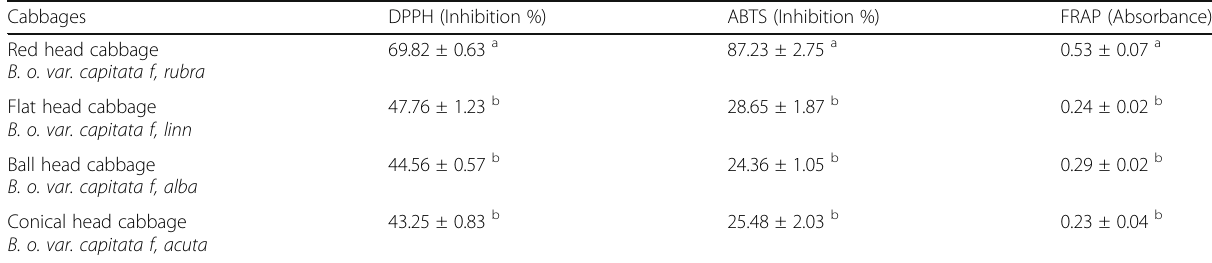
Table 4 Antioxidant activity of head cabbages